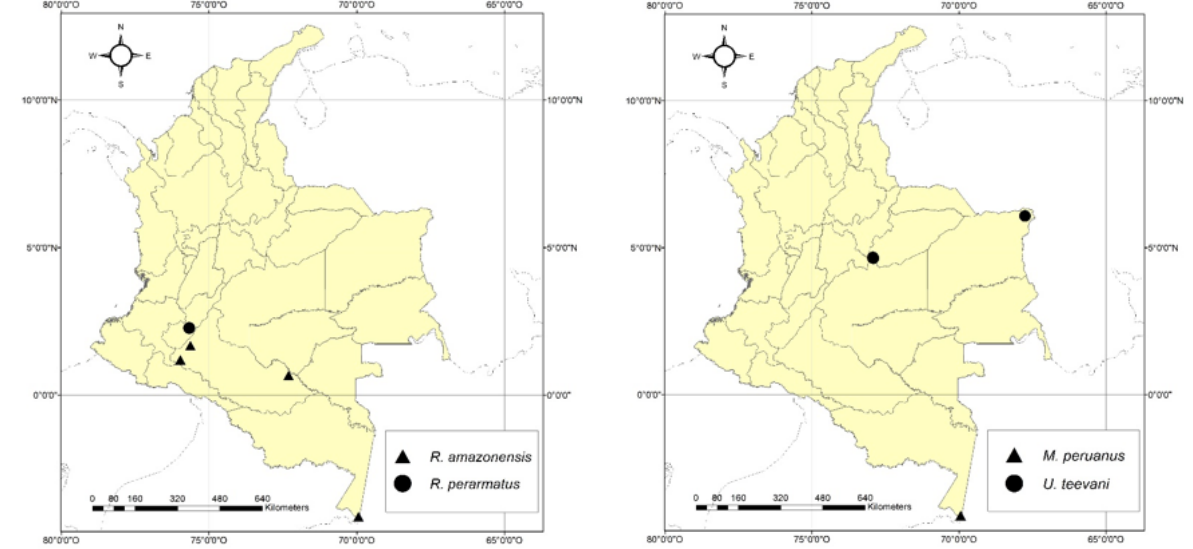
Figure 3. Distribution map of Rhynchotermes amazonensis and Rhynchotermes perarmatus .